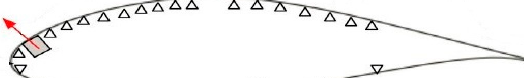
Figure 8. Wall pressure measurements and XFoil predictions for Re = 320,000, α = 0 degrees ( top ) and α = 4 degrees ( bottom ).